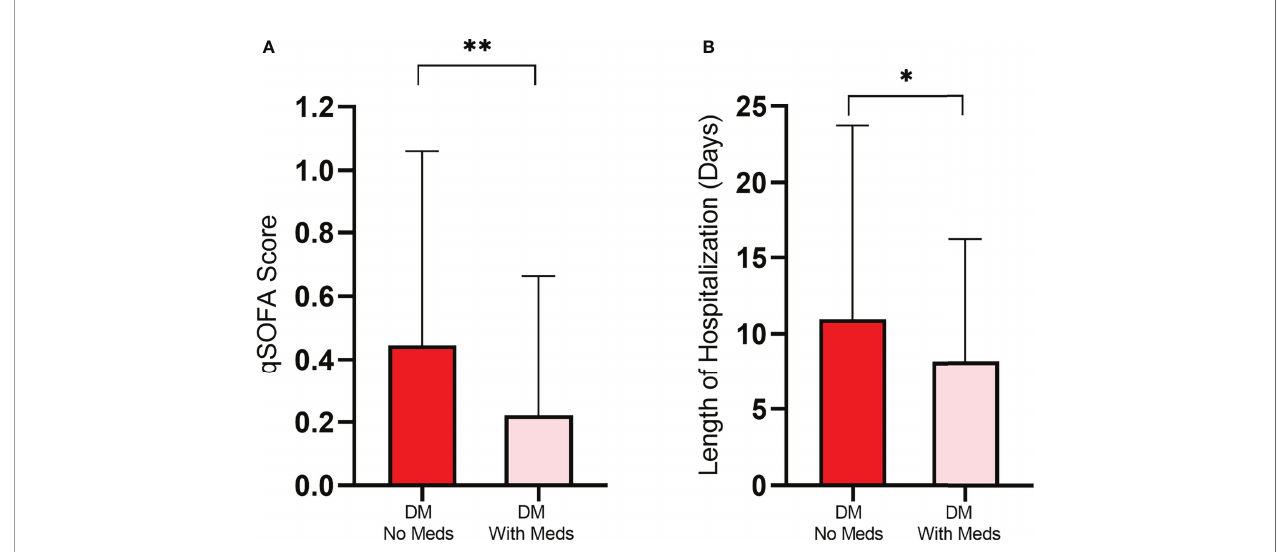
FIGURE 1 | Severity (A) and length of hospital stay (B) among hospitalized COVID-19 patients with diabetes (DM) were signi fi cantly greater in patients with unmanaged diabetes (without medication) compared to patients who managed their diabetes with medication. Data presented as mean ± SD. *p<0.05,